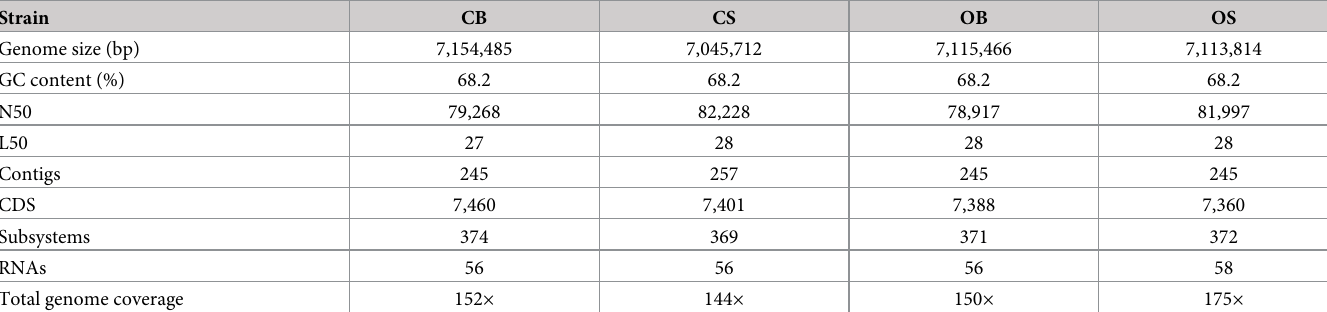
Table 2. General genomic features of four Burkholderia pseudomallei draft genomes.